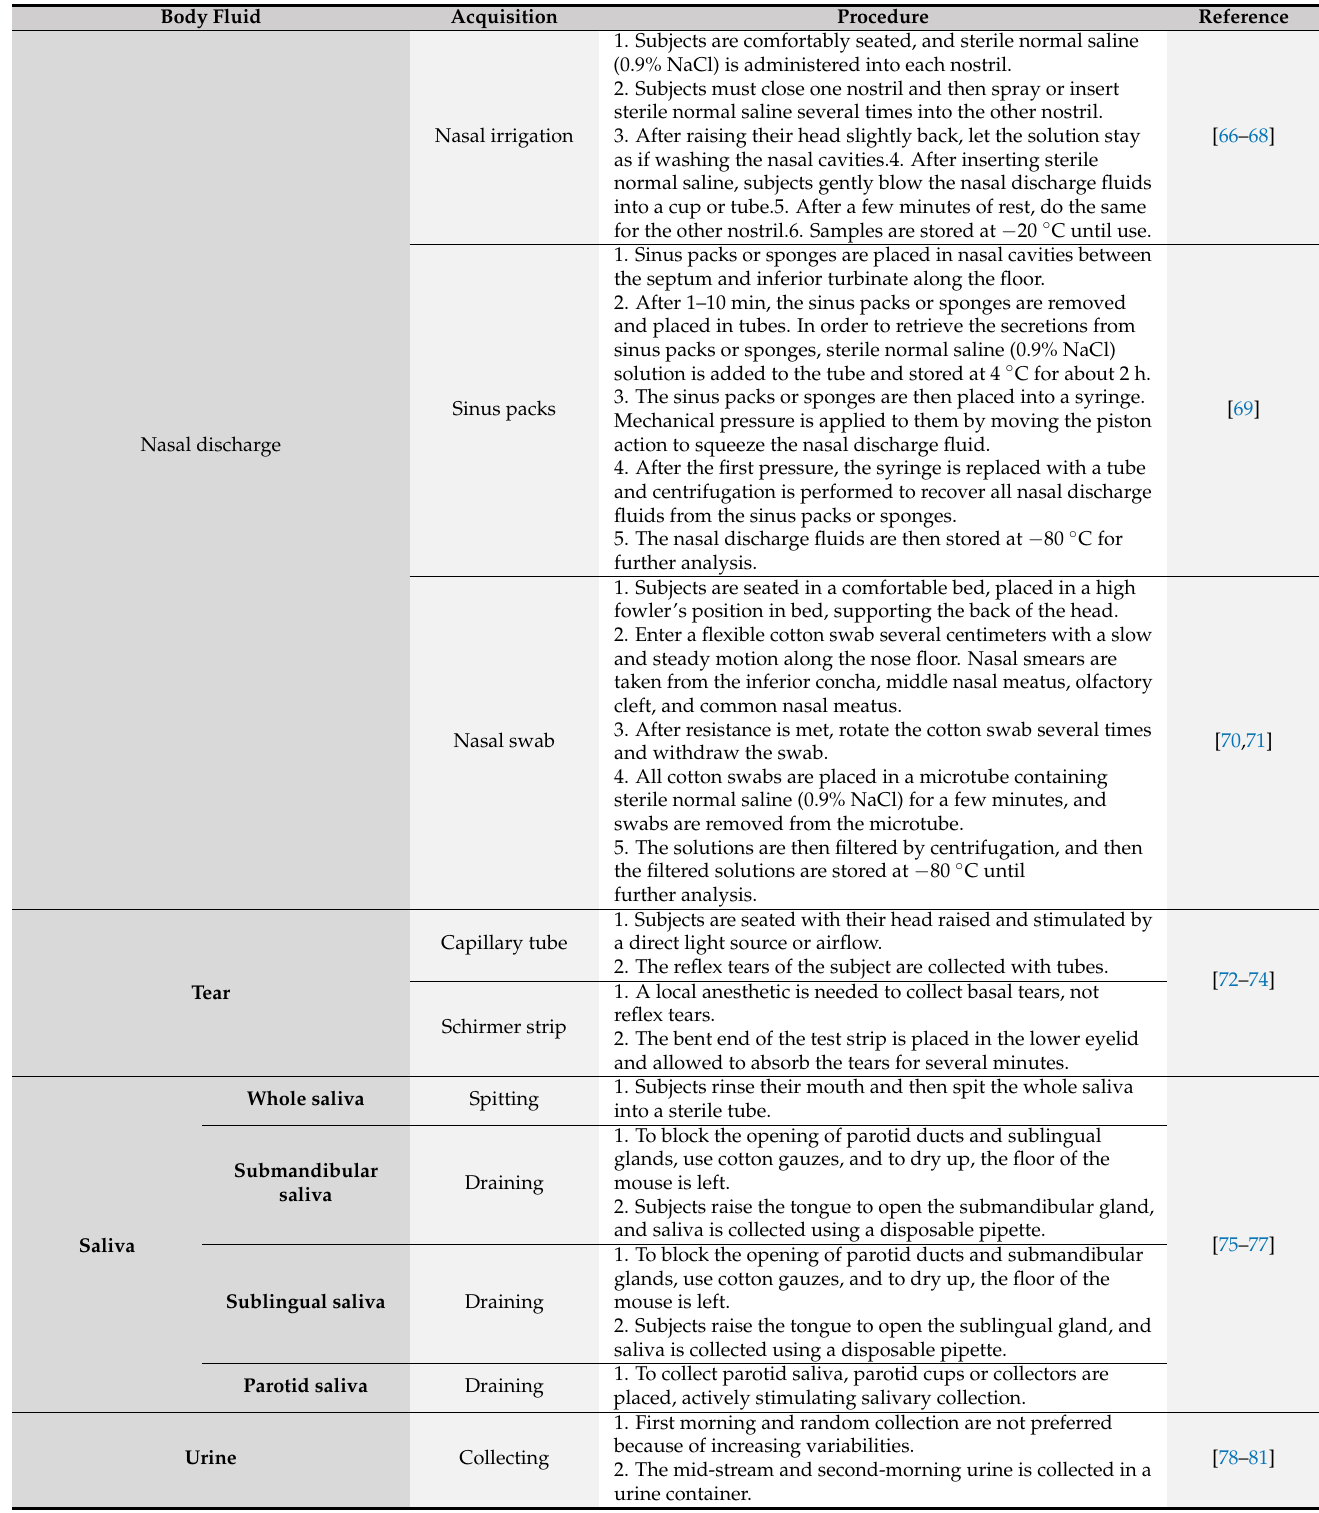
Table 6. Summary of acquisition procedures for nasal discharge, tear, saliva, and